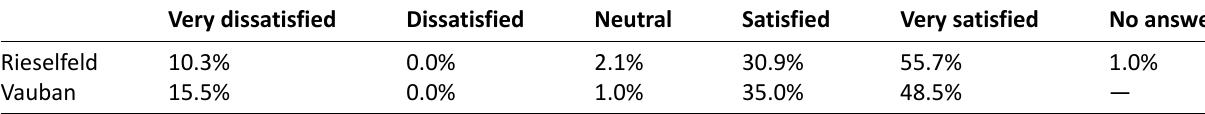
Table 5. Overall level of satisfaction with living in Rieselfeld/Vauban.